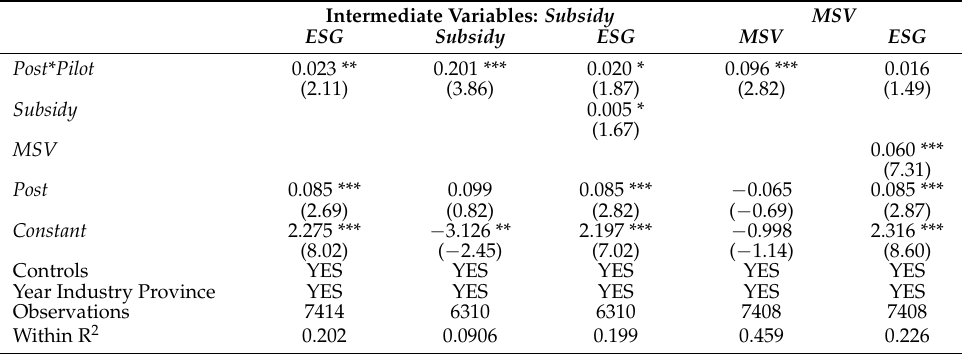
Table 5. Social mechanism: Subsidy and MSV . Intermediate Variables: